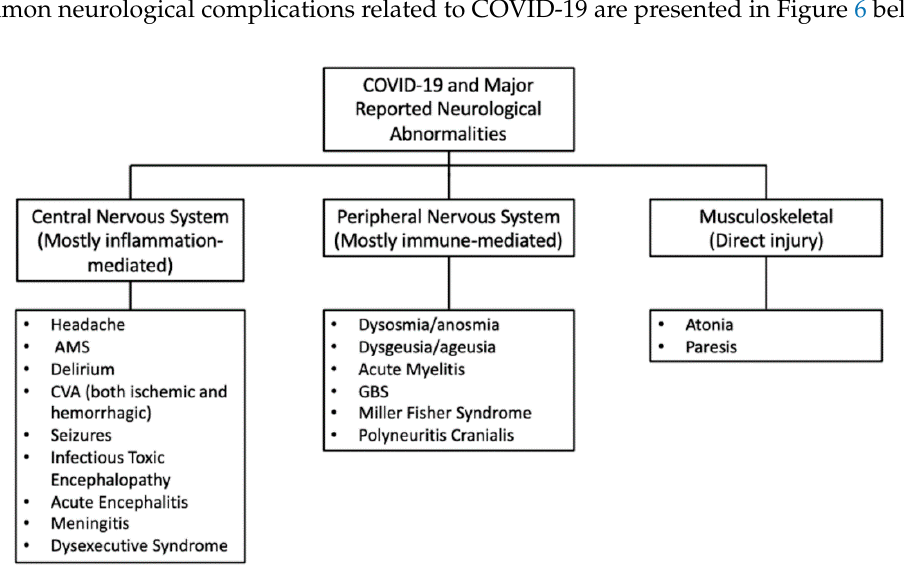
Figure 6. Major neurological abnormalities reported in COVID-19 [87]; AMS—Altered mental status; CVA—Cerebrovascular accidents; GBS—Guillain-Barre syndrome.